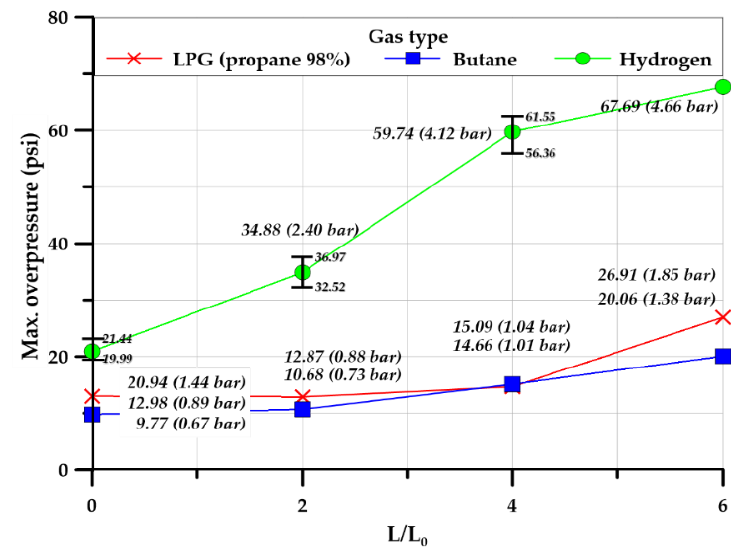
Figure 17. Maximum overpressure in the square-type chamber .